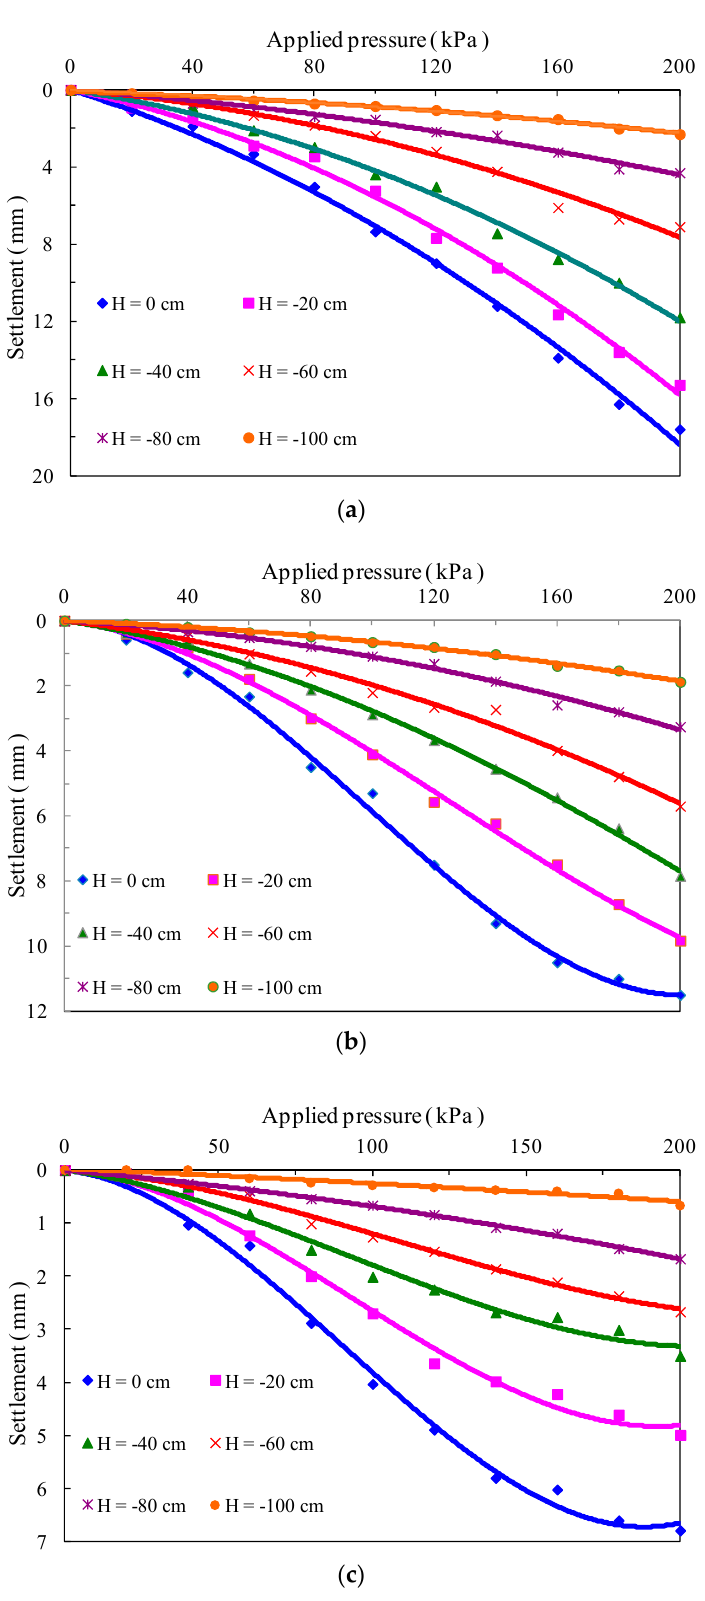
Figure 7. Applied pressure-settlement curves for unreinforced and reinforced subgrade models. ( a ) Unreinforced subgrade model; ( b ) fiber-reinforced subgrade model; ( c ) fiber-cement-reinforced subgrade model.